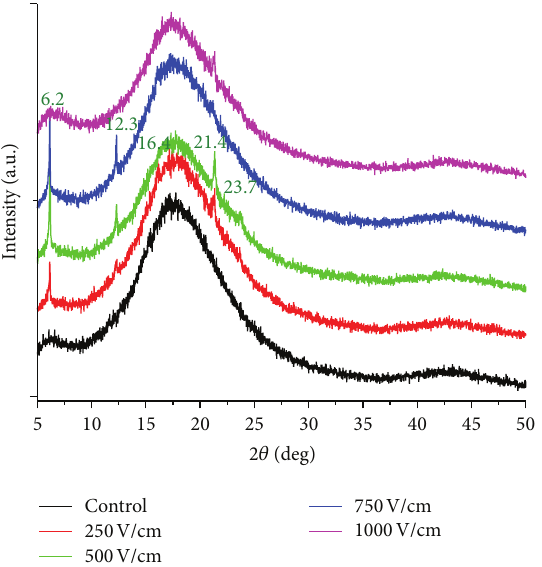
Figure 4: Diffractogram of epoxy cured in AC electric fields.